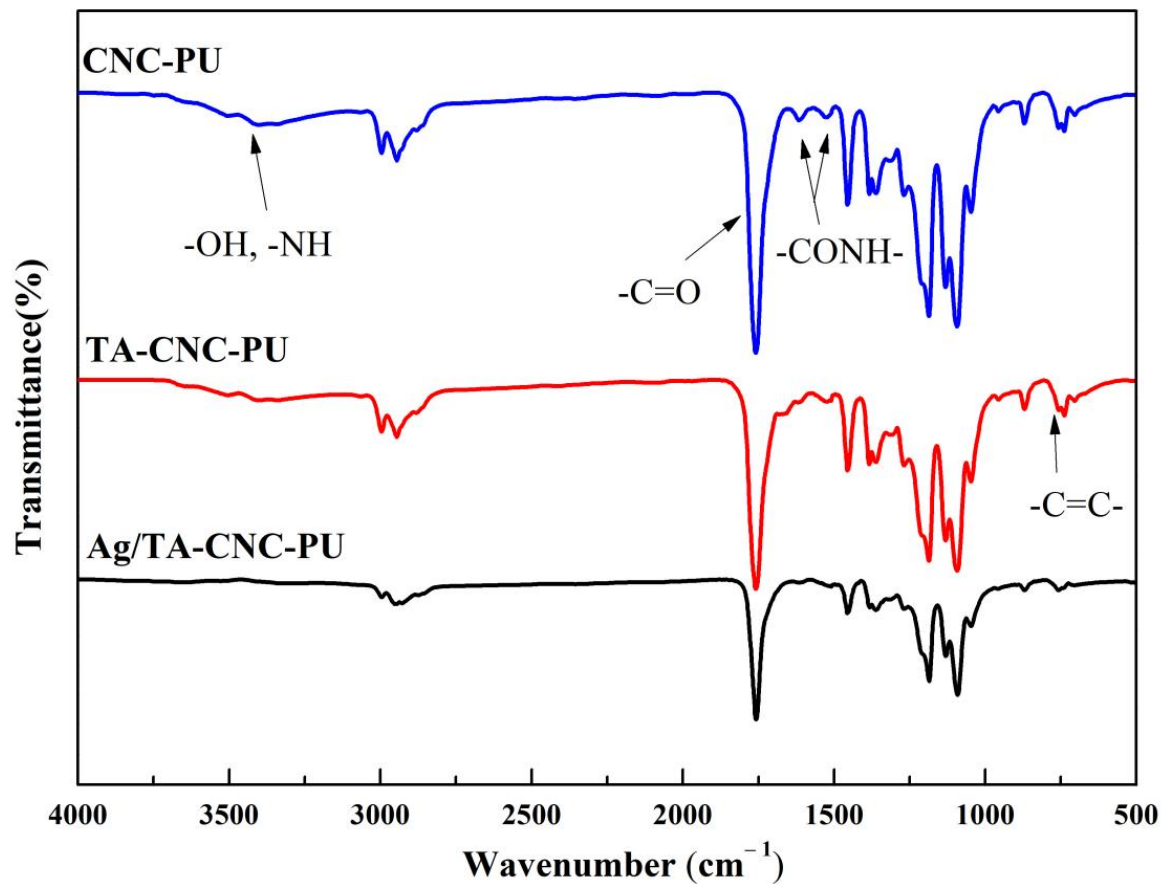
Figure 2. The FT-IR spectra of CNCs-based PUs.